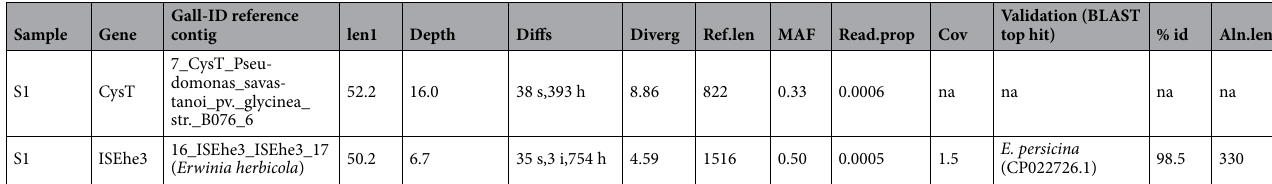
Table 2. NGS read mapping onto known reference genes of gall-inducing bacteria in Gall-ID. Validation was done by BLAST searches of assembled contigs. *And other equivocal hits; ** Agrobacterium tumefaciens (CP032922.1), Agrobacterium sp. H13-3 (CP002249.1); *** Agrobacterium sp. H13-3 (CP002249.1); **** Agrobacterium tumefaciens (CP032922.1); % id = percent identity (BLAST); aln. len = alignment length (BLAST); cov = coverage, k-mer based (assembled contig); diffs = differences between subject and reference (Gall-ID): s = snp, i = indel, h = hole; diverg = divergence; len1 = length coverage of reference